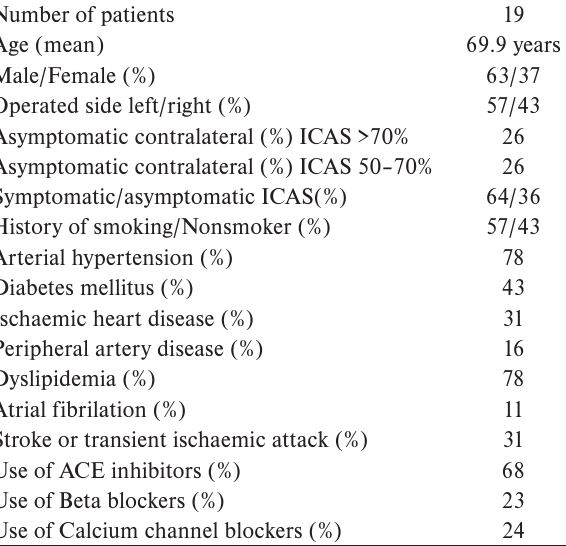
Table 1. Clinical charasteristics of